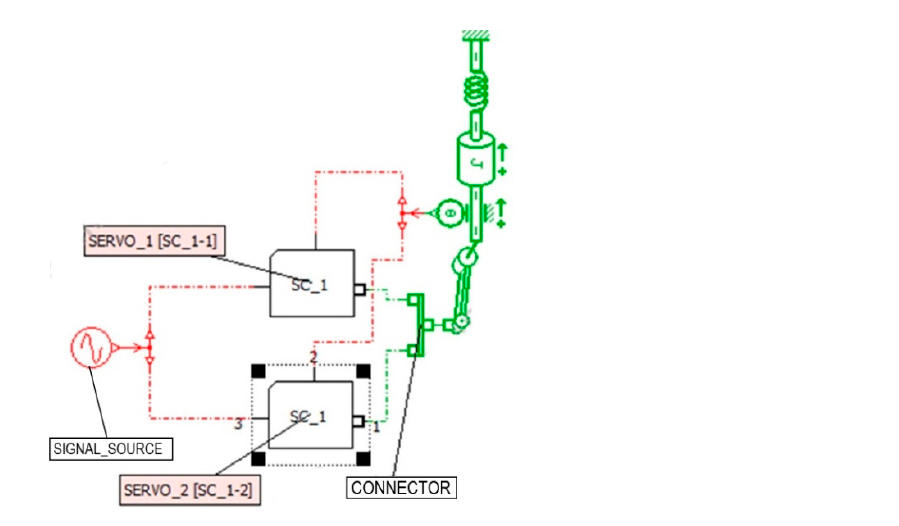
Figure 2. Aileron drivenby two redundant electro-hydrostatic servo-actuators. The aileron is considered to be subject to rotational inertia, and is linked to a rotation spring that represents the aerodynamic forces. Aileron inertia was considered to be 7.98 kgm 2 and a value of 306 Nm/° was assumed for the spring elastic constant.